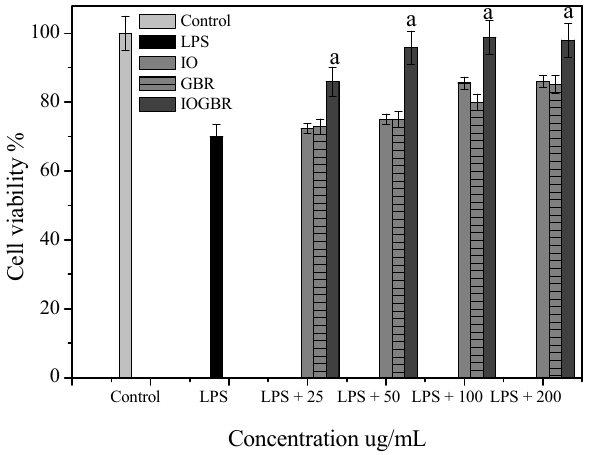
Figure 3. Cell viability of the extracts from Inonotus obliquus (IO), germinated brown rice (GBR) and Inonotus obliquus grown on germinated brown rice (IOGBR) on LPS induced Raw 264.7